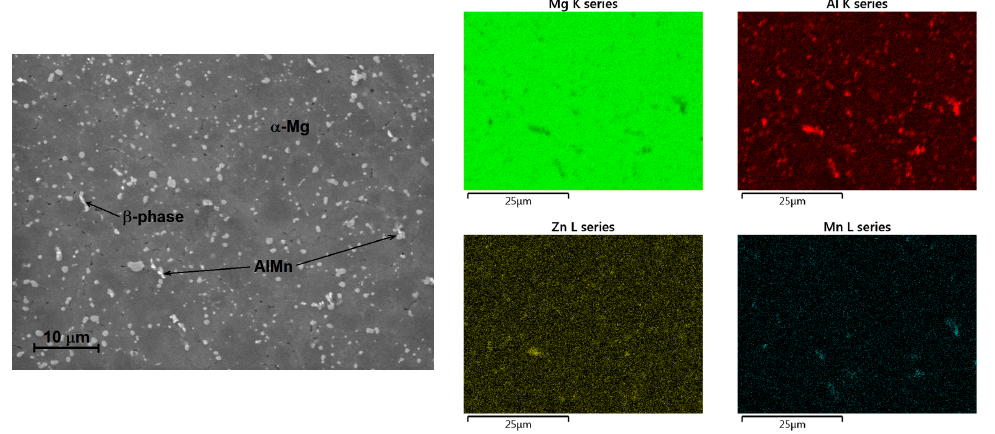
Figure 2. Microstructure of AZ61 magnesium alloy (SEM) with EDS maps of the elements distribution: magnesium (Mg), aluminum (Al), zinc (Zn) and manganese (Mn). Table 3. Chemical composition of AZ61 magnesium alloy (EDS).